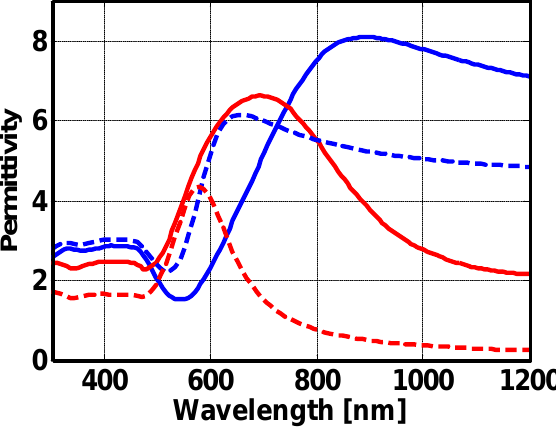
Figure 5. Effective properties of a gold nanocomposite with a filling fraction of